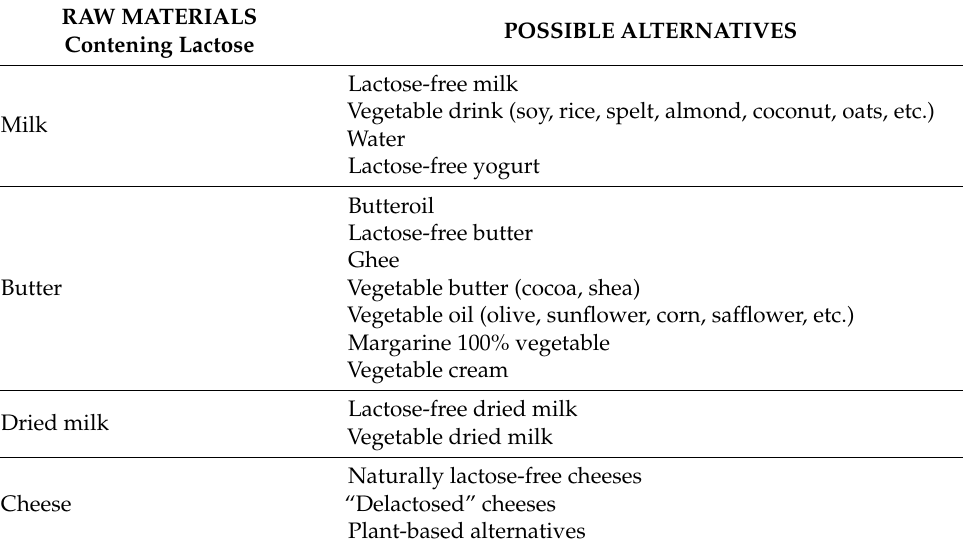
Table 4. Ingredients containing lactose and their possible